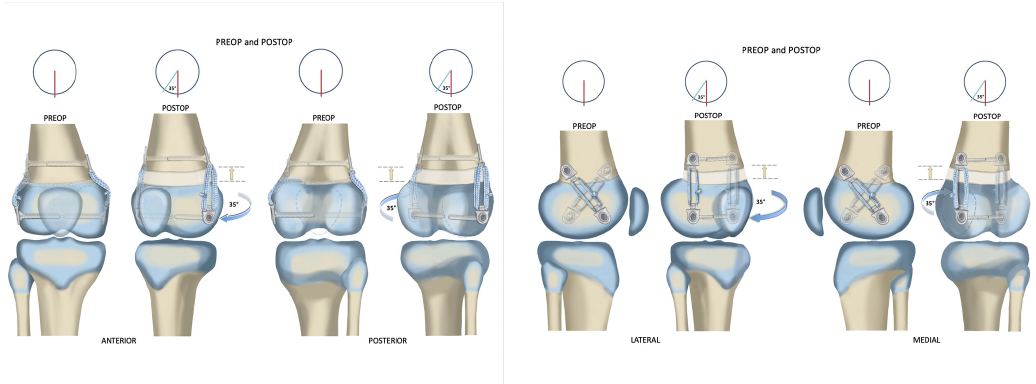
Figure 4. Anterior, posterior, lateral, and medial views of correction before and after rotationally guided growth correction. lllustrations copyright to Paley Foundation; reprinted with permission.